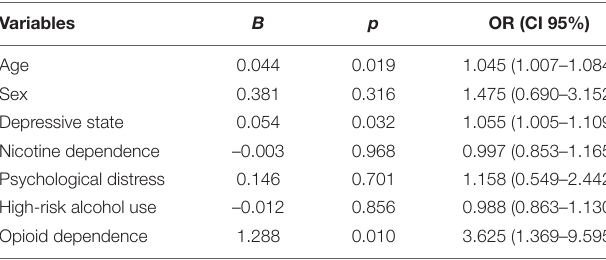
TABLE 4 | Logistic regression on sexual dysfunction prevalence in the total sample ( n =